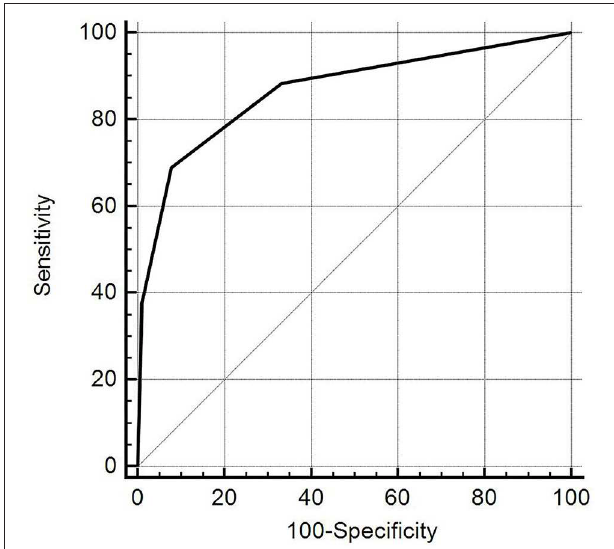
FIGURE 4 | The diagnostic accuracy of the diffuse thyroid disease (DTD)-thyroid imaging reporting and data system (TIRADS) for detecting DTD in 270 patients (when the selected cut-off criterion was category III). The diagonal line represents 50% of the area under the receiver operating characteristic curve and refers to a hypothetical marker that has no discriminatory power for differentiating DTD from normal thyroid